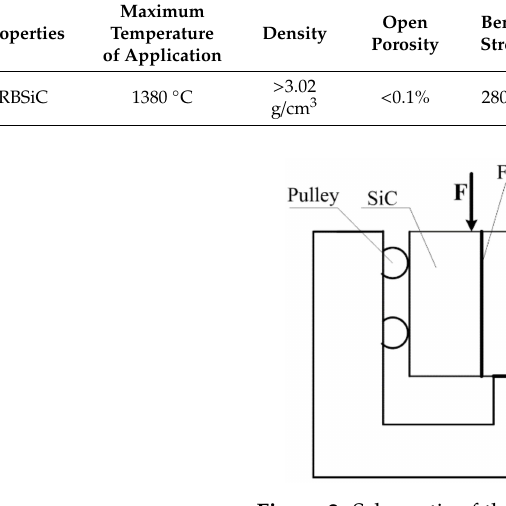
Figure 2. Schematic of the shear strength